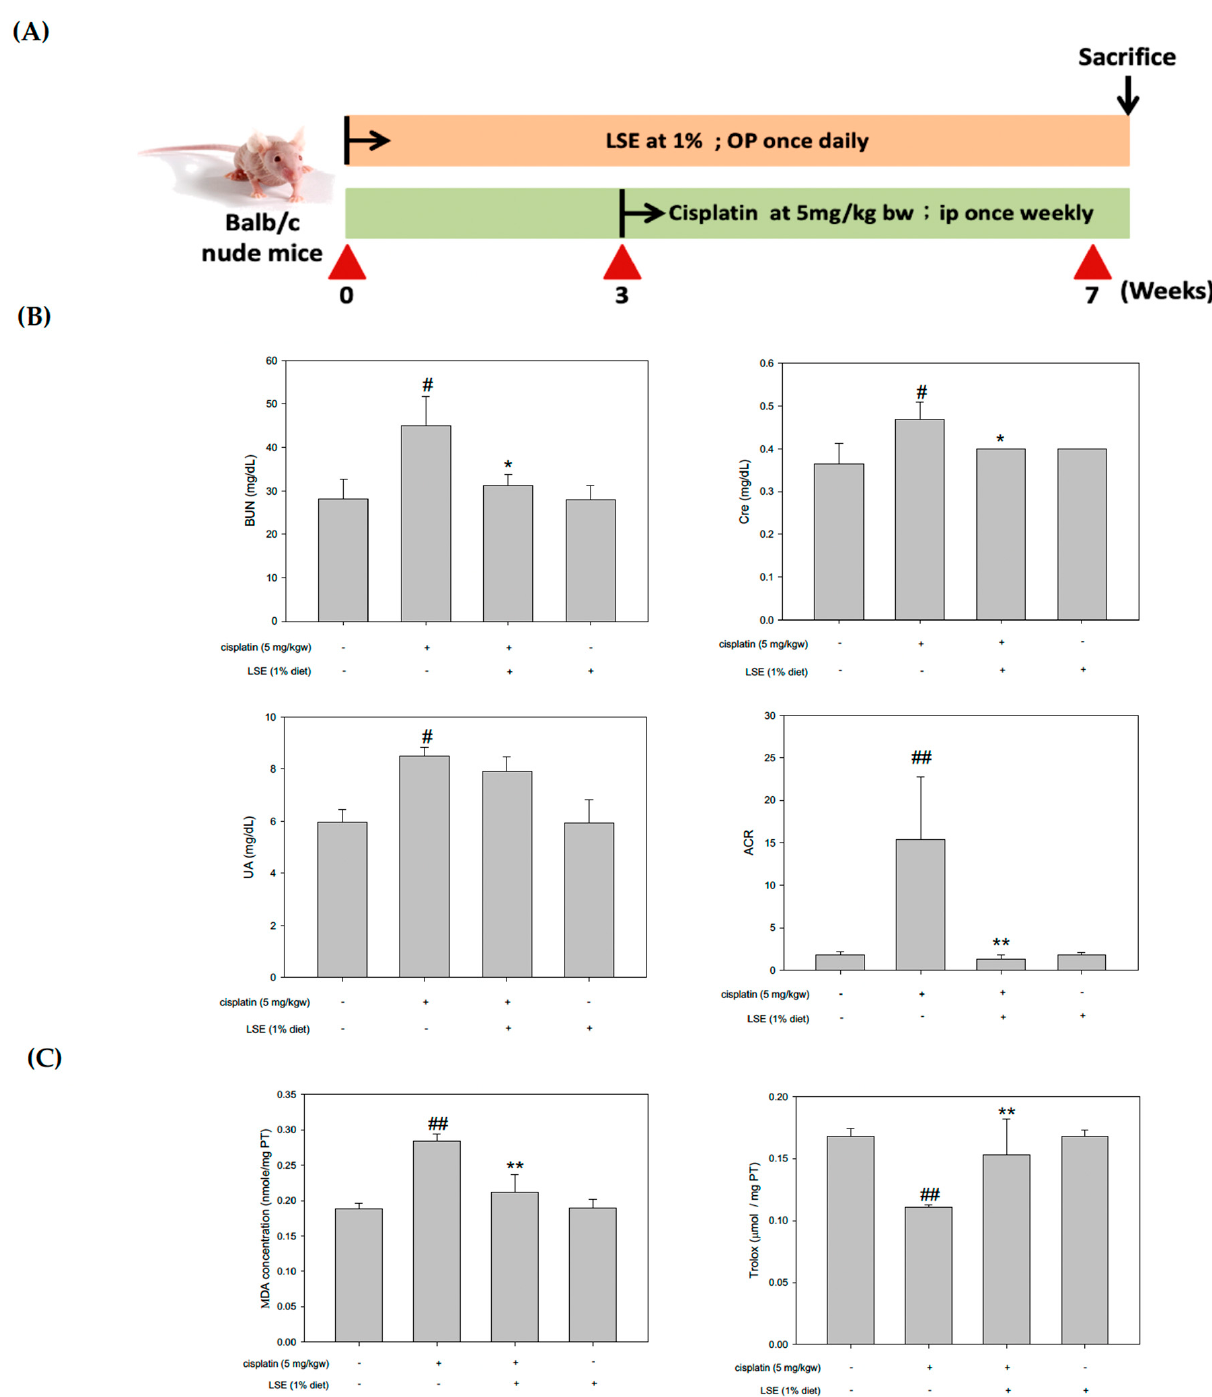
Figure 5. Effects of LSE on the kidney biochemical parameters, lipid peroxidation, and antioxidant capacity in nude mice induced by cisplatin treatment. ( A ) BALB/c nude mice model and workflow ( B ) Serum BUN (Blood urea nitrogen), Cre (creatinine), UA (urea acid) and urine ACR (albumin to creatinine ratio) levels were analyzed. ( C ) The lipid peroxidation of the kidney was assessed by measuring the TBARS assay and the antioxidant capacity of the kidney was assessed by measuring the TEAC assay. Quantification data were presented as mean ± SD of three independent experiments by using Sigma plot 10.0 software. # p < 0.05, ## p < 0.01 compared with the control group; * p < 0.05, ** p < 0.01 compared with the cisplatin group.